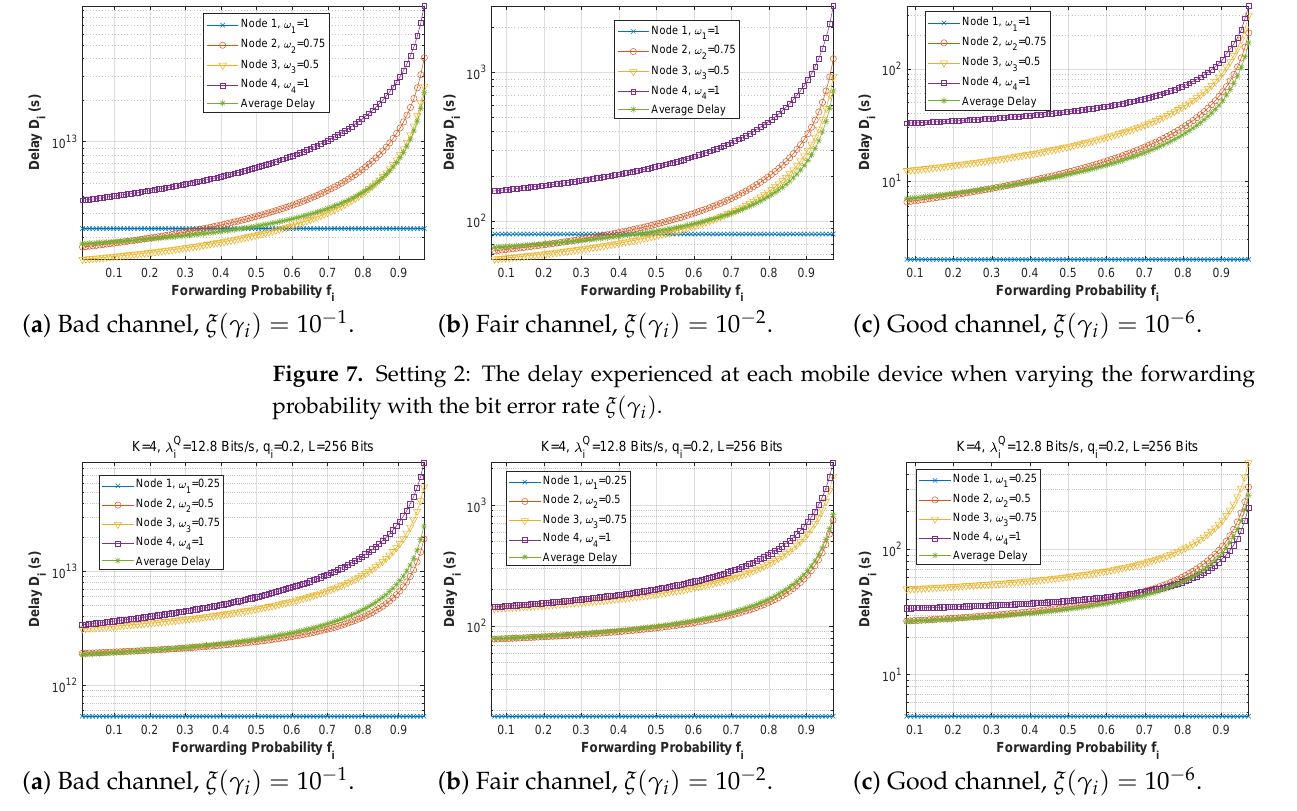
Figure 8. Setting 3: The delay experienced at each mobile device when varying the forwarding probability with the bit error rate ξ ( γ i ) .